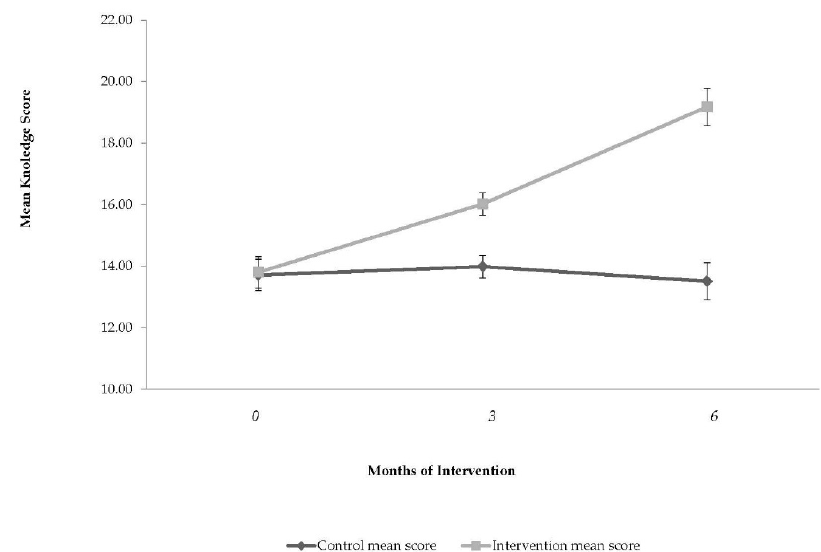
Figure 2. Changes in mean score for children’s nutritional knowledge by study arm at three months and six months from baseline. Vertical bars indicate standard errors, p -value for intervention group, time, and interaction between time and group. To statistically evaluate the changes in children’s nutritional knowledge score over time, generalized estimating equations were used, with the control group as the reference group. The explanatory variables were: time from baseline, school cluster, and intervention group.